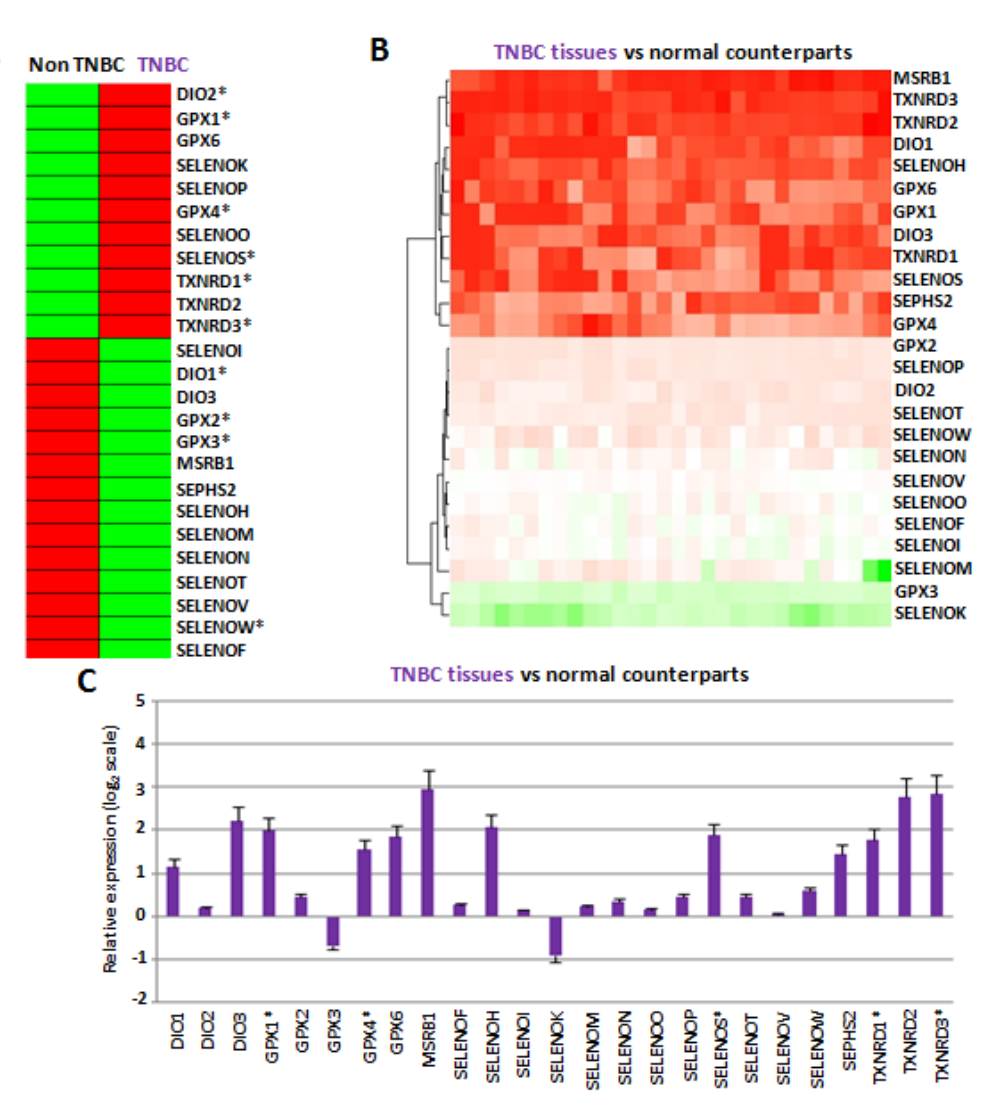
Figure 2. ( A ) Comparison between the mean gene expression profiles of each selenoprotein in TNBC cells and other cellular subtypes obtained considering together ER/PR positive, HER2 positive, ER/HER2 and PR/ER/HER2 positive subtypes, named “non-TNBC” by clustering analysis. Asterisks indicated the selenoproteins that in our cellular studies presented expression trends equal to CCLE and LINCS datasets. ( B ) Comparison between the gene expression profiles of each selenoprotein in thirty TNBC tissues compared to the related normal counterparts. ( C ) Mean fold changes of gene expression levels for each selenoprotein in all TNBC tissues compared to the all normal counterparts, evaluated by the 2 −ΔΔCq method and reported as log 2 scale. We consider values higher and lower than +1 and − 1, respectively, statistically significant. We evidenced with ‡ the se- lenoproteins that presented similar expression trends in both TNBC cells and tissues, and CCLE and LINCS datasets.